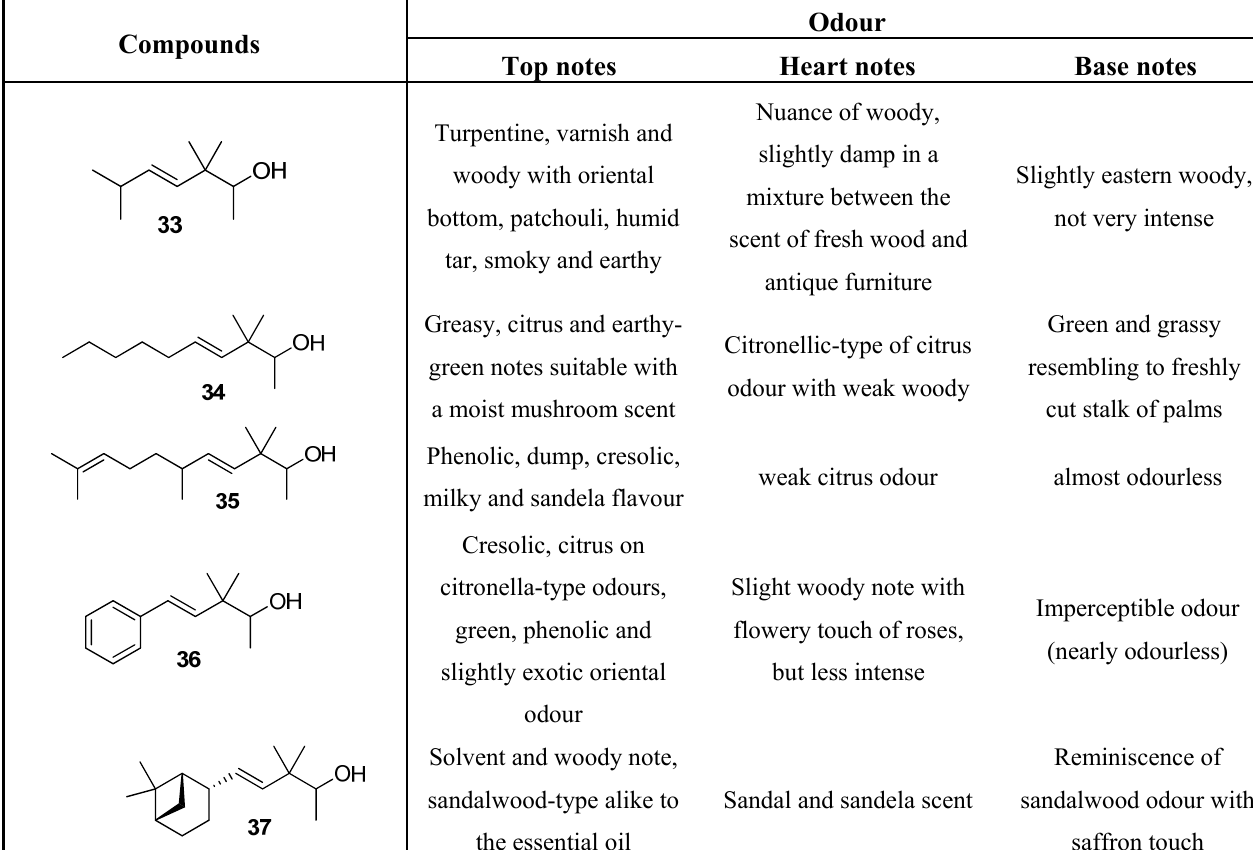
Table 1. Odour evaluation of alcohols 33 – 37 from impregnated blotting paper strips. Compounds